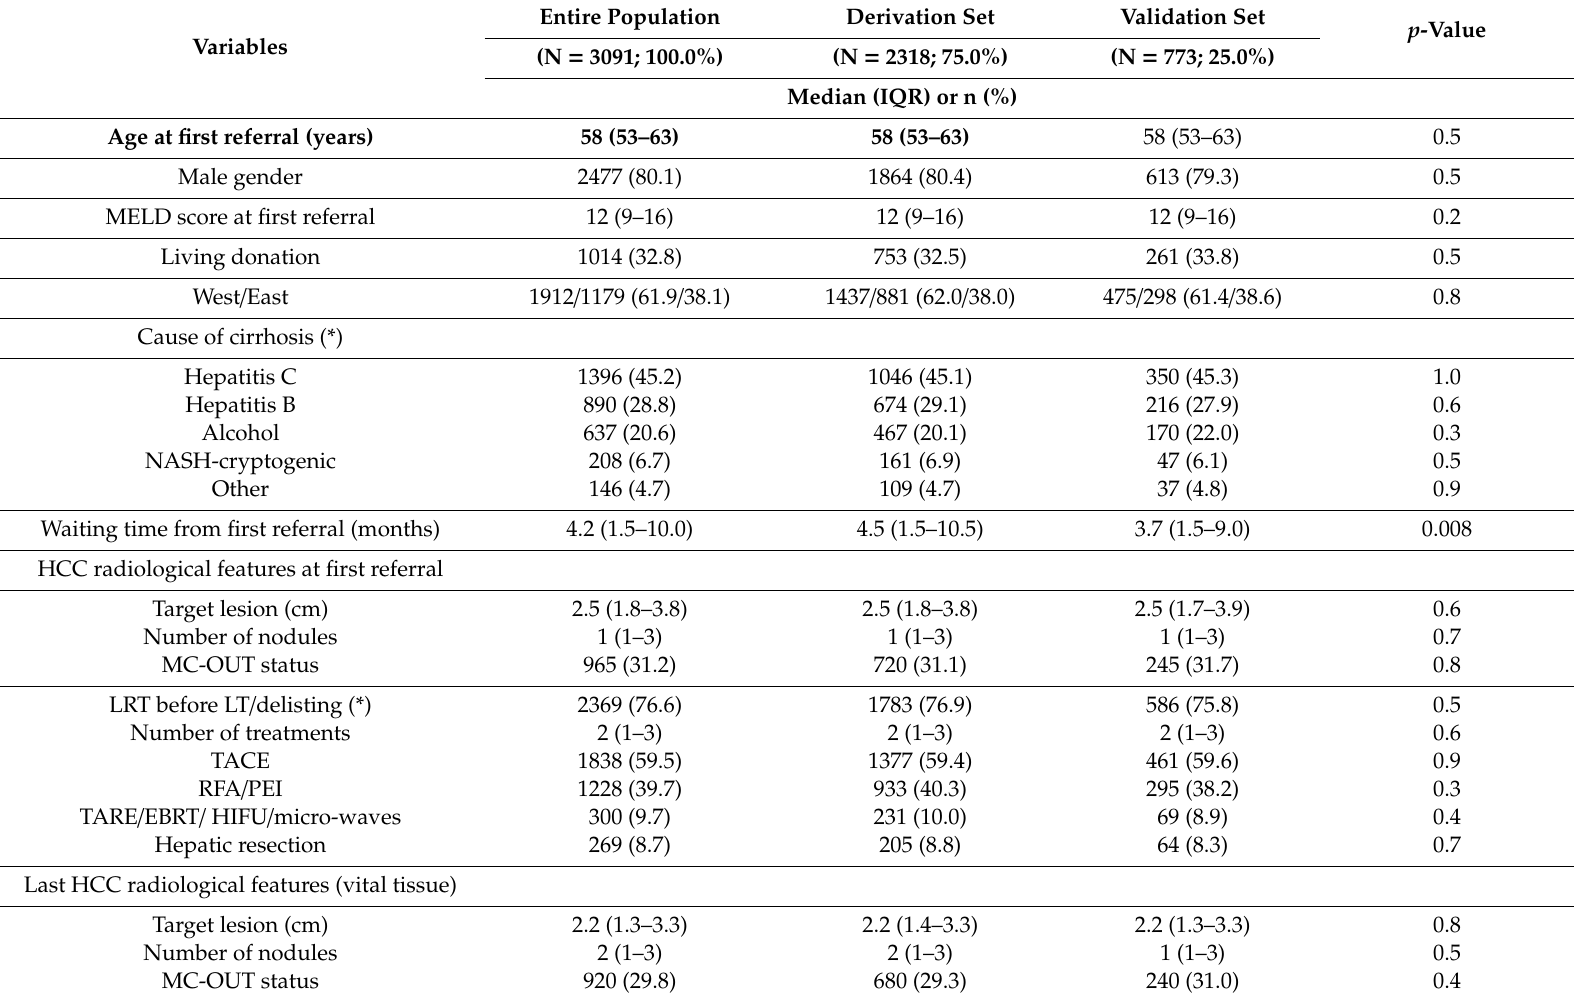
Table 1. Demographics and tumor characteristics in the Derivation and Validation